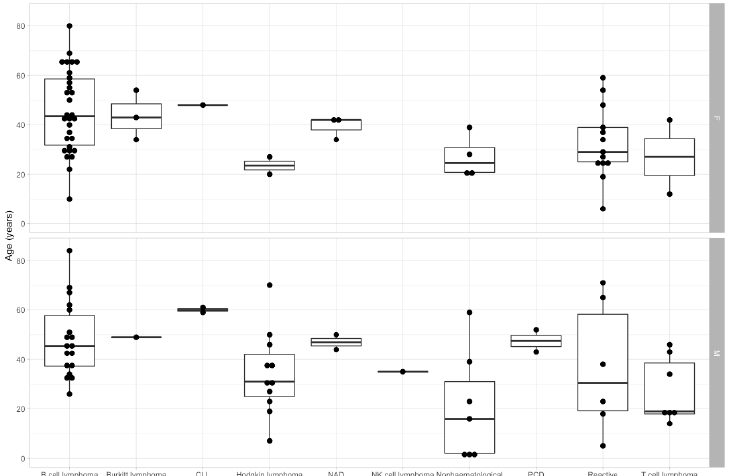
Figure 4. Patient’s age and sex distribution between different histological diagnoses. PCD: plasma cell dyscrasia; NK cell lymphoma: natural killer cell lymphoma; Non-hematological: non-hematological malignancy. CLL – chronic lymphocytic leukemia. NAD – No abnormality detected.